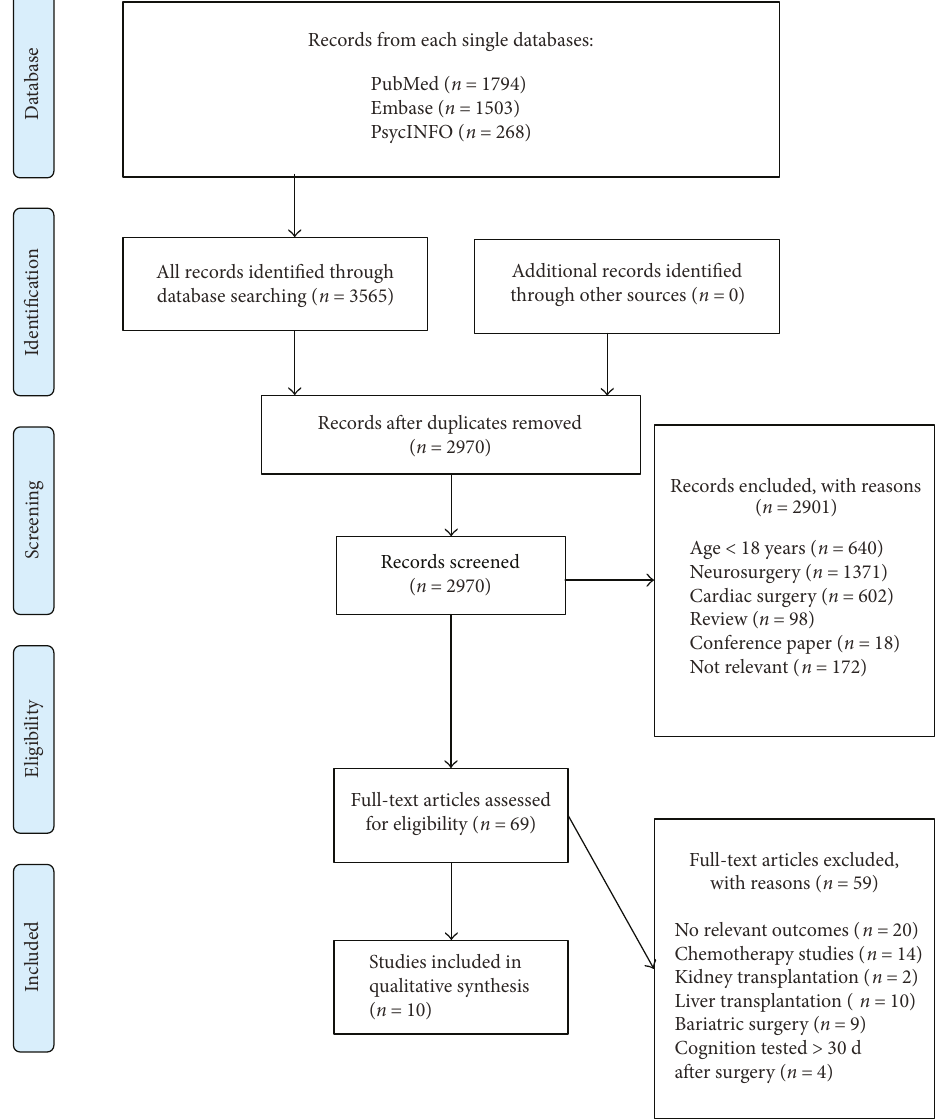
Figure 1: Flowchart of study